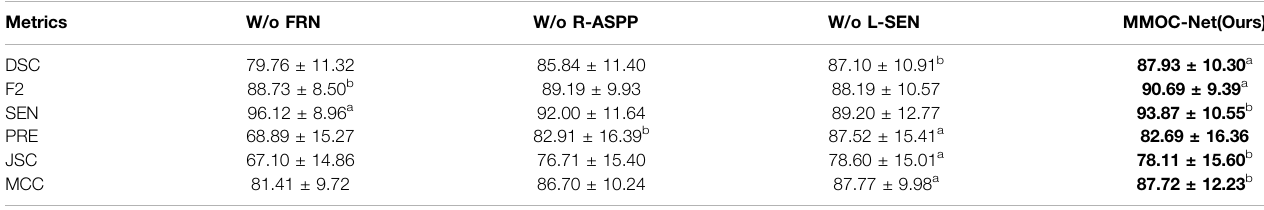
Bold values represent the best results in the table. W/o, without; FRN, full-resolution network; R-ASPP, atrous spatial pyramid pooling; L-SEN, Loss of